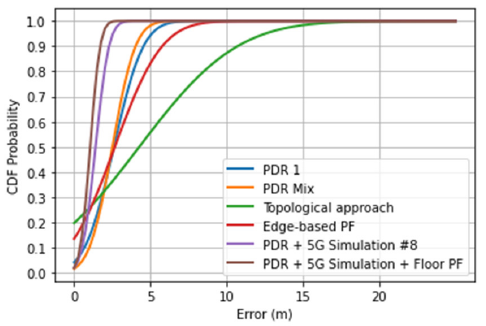
Figure 12. Evaluation of different implemented approaches altogether.